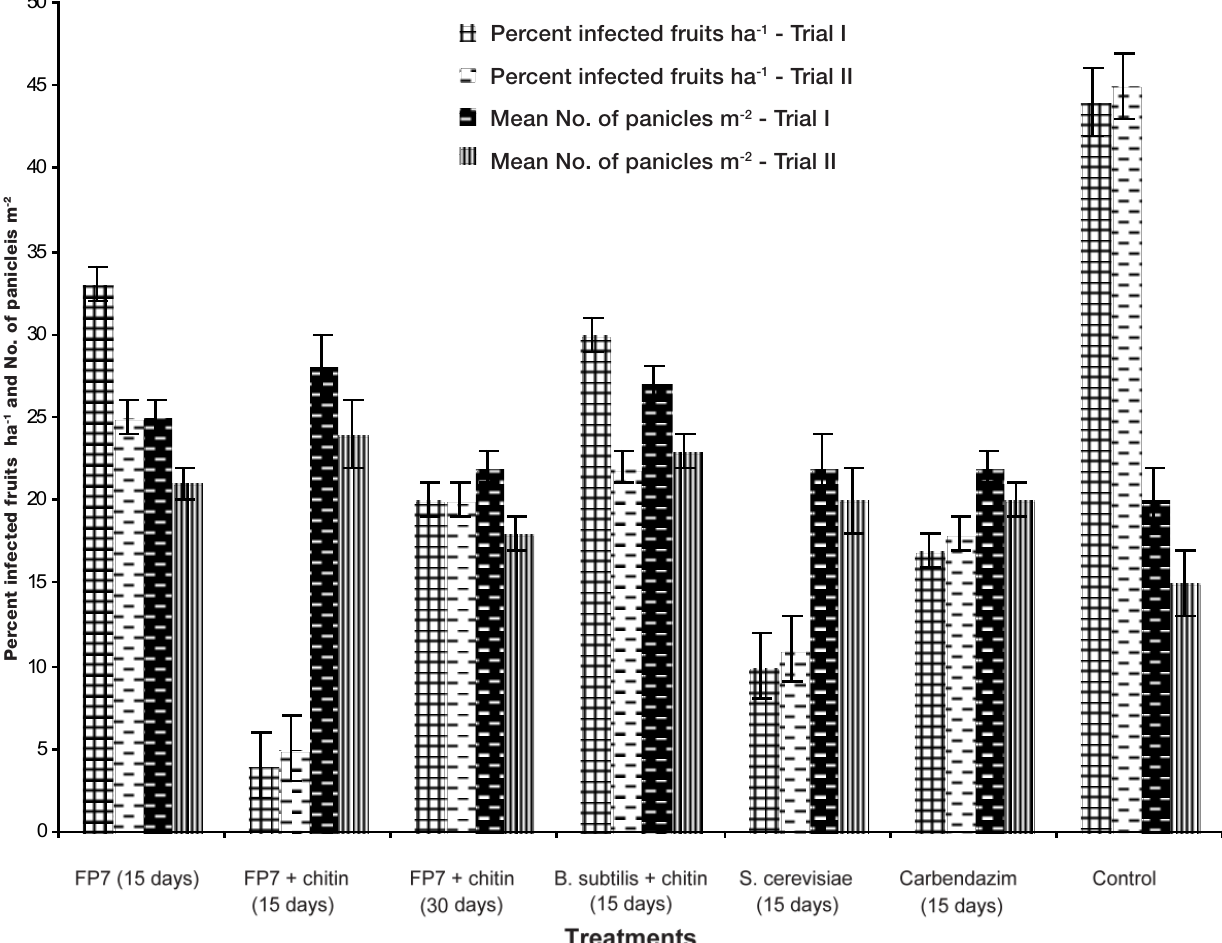
Fig. 3. Effect of pre-harvest application of biocontrol formulations on yield parameters of